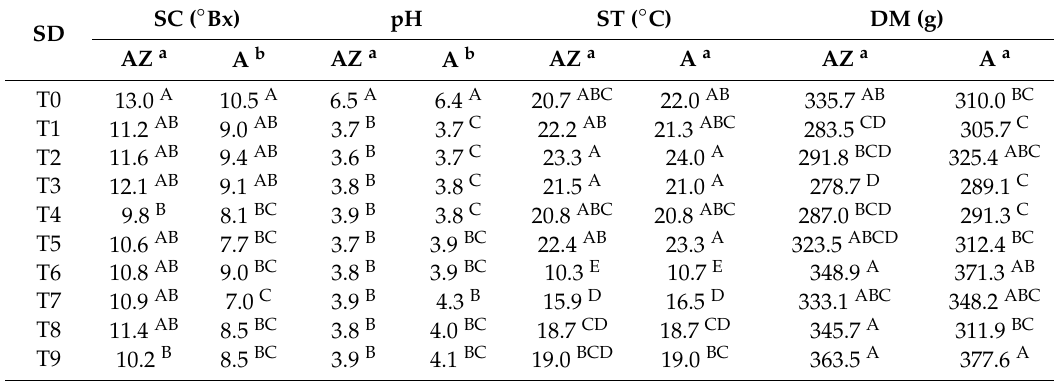
Table 1. Chemical and physical characteristics of Amarillo Zamorano (AZ) and A (A) silages. SC ( ◦ Bx) pH ST ( ◦ C) DM (g) SD A b AZ